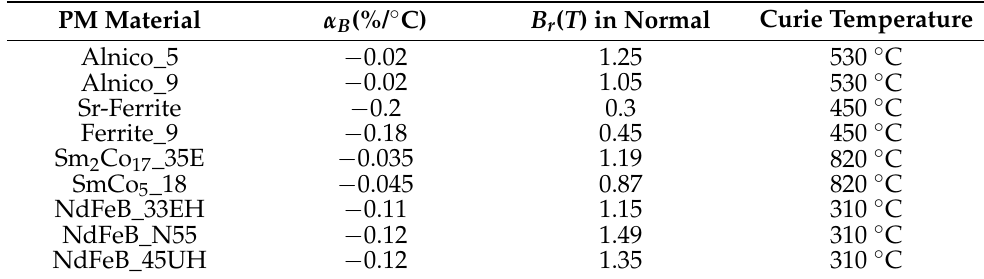
Table 1. The parameters of typical permanent magnet materials.